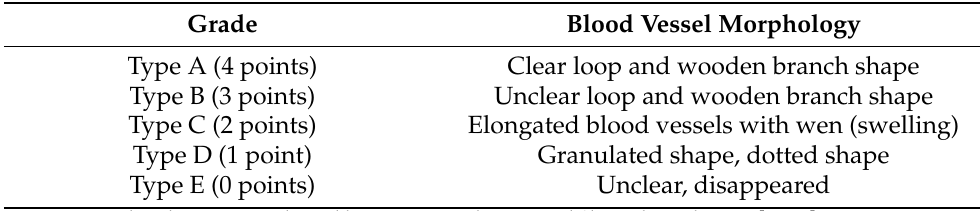
Table 1. NBI Morphological Blood Vessel Evaluation Grading